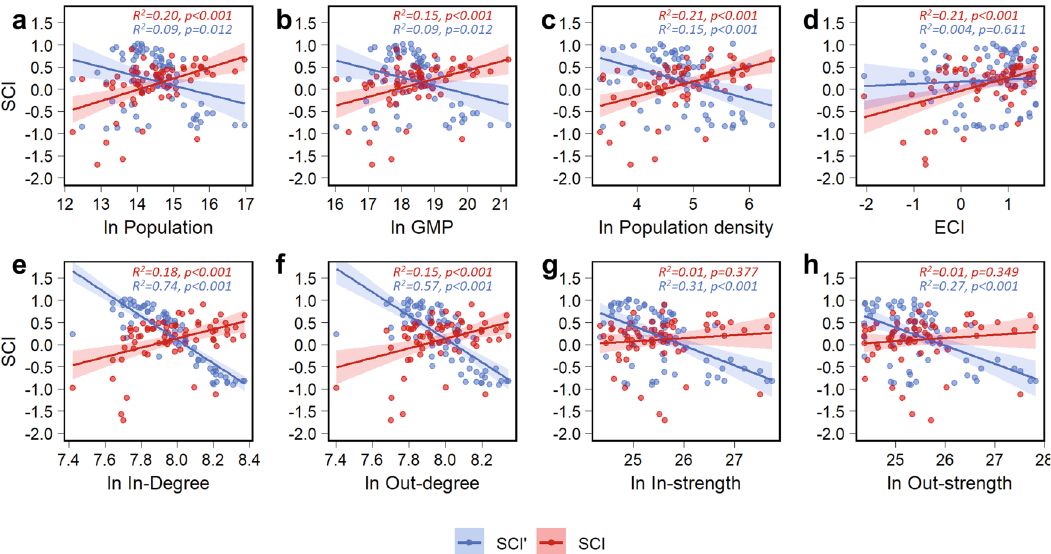
Fig. 2 Trade-off pattern between horizontal and vertical supply chain complexity. a – d Relationships between supply chain complexity and local city characteristics for 2012 [ln population, ln gross metropolitan product (GMP), ln population density, and standardized economic complexity index (ECI)]. e – h Relationships between supply chain complexity and local supply network characteristics for 2012 [in-degree (total number of suppliers), out-degree (total number of exporting regions), in-strength (total in fl ows), and out-strength (total out fl ows); all in ln scale]. Local supply network characteristics are calculated by aggregating all the supply networks for 2012. For each plot, n = 69 with each point representing a city. The best linear fi ts are also shown, together with their 90% con fi dence intervals, R 2 values, and p